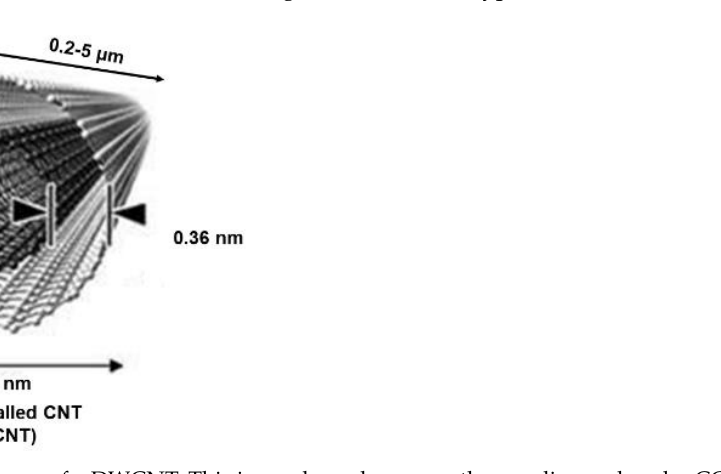
Table 8. Possible Associations between the different known allotropes of carbon and particular morphologies of CNTs.